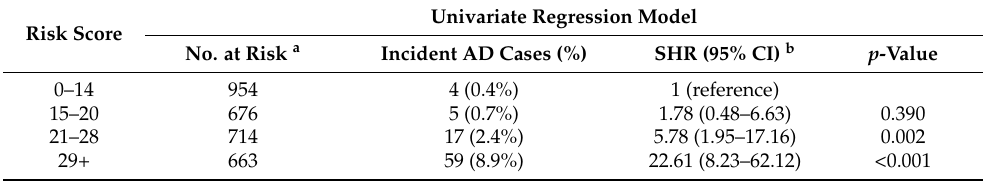
Table 3. Fine and Gray regression model relating the score quartiles with risk of AD.